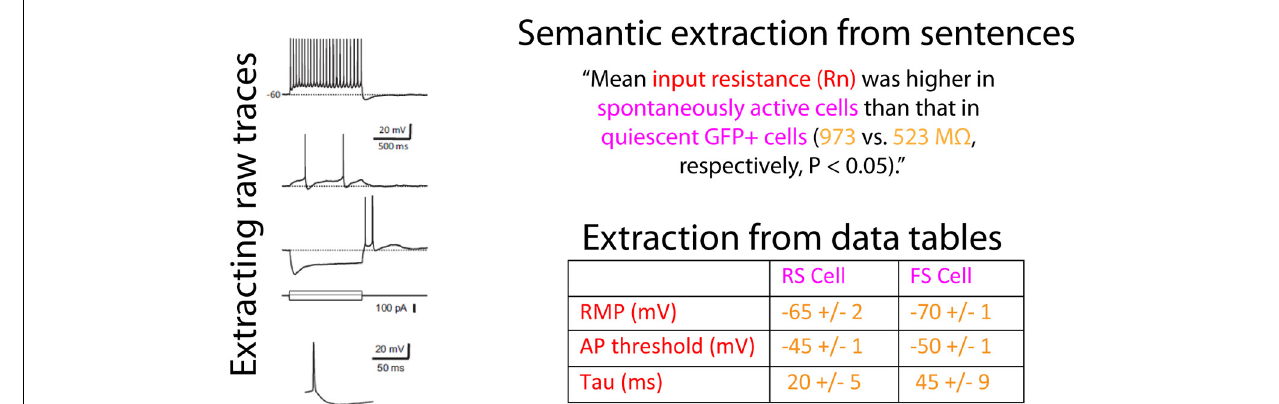
FIGURE 2 | Illustration of the sources within an article containing information relevant to neuron electrophysiological properties. Data on neuronal electrophysiological properties are presented within article figures and raw traces, sentences within the article text, and formatted data tables. The raw traces and example sentence are